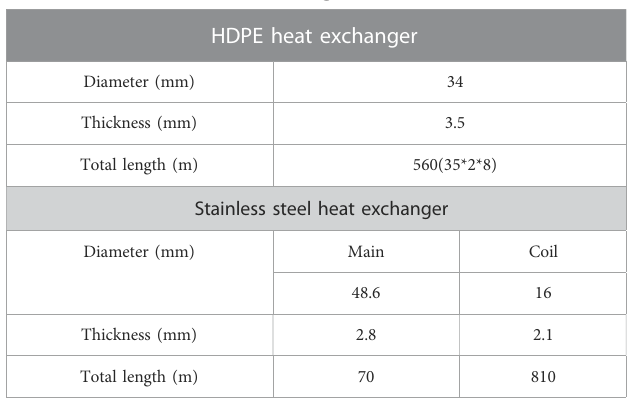
TABLE 2 Dimensions of the heat